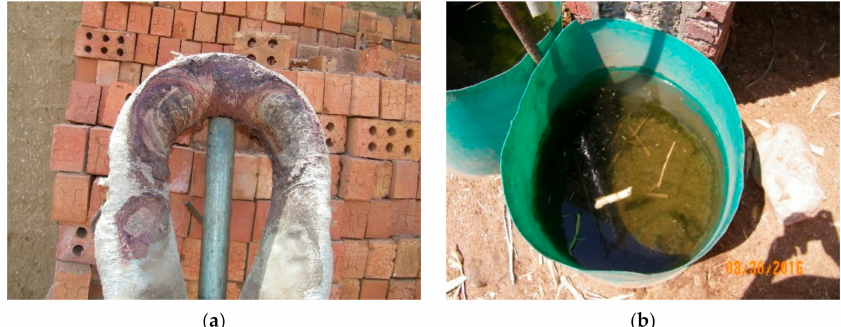
Figure 4. Examples of parameters compromising working donkey welfare including ( a ) a dirty neck collar, and ( b ) unclean water.